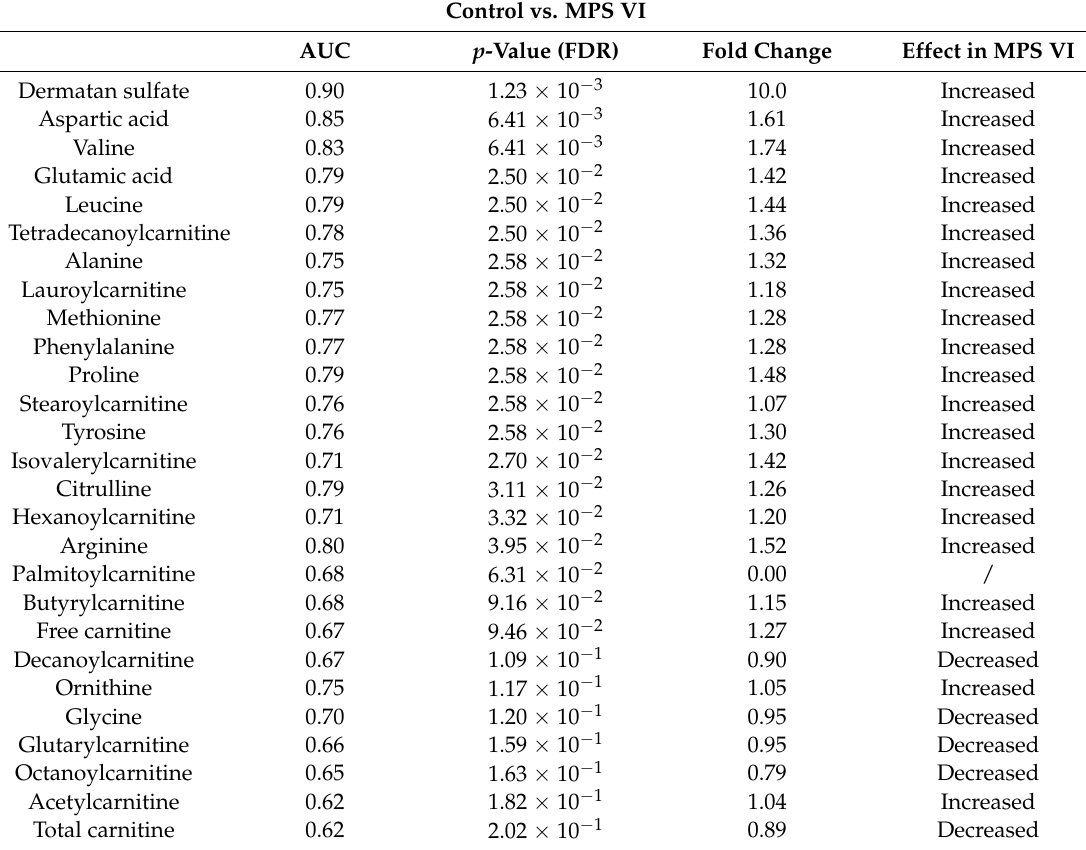
Table 3. The normalized concentrations of dermatan sulfate, free amino acids, carnitine (total and free), and acylcarnitines in urine samples of the MPS VI and control groups. ( µ M/mM